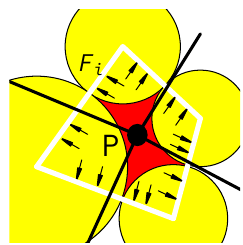
Figure 2. Pressure distribution in the fluid